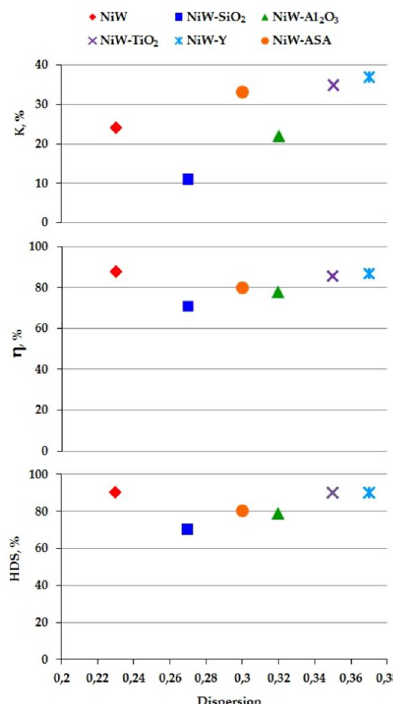
Figure 4. Dependence of the degrees of conversion (K), hydrodearomatization (η), and hydrodesulfurization (HDS) of VGO on the dispersion (390 °C, 5.0 MPa, 5 h).